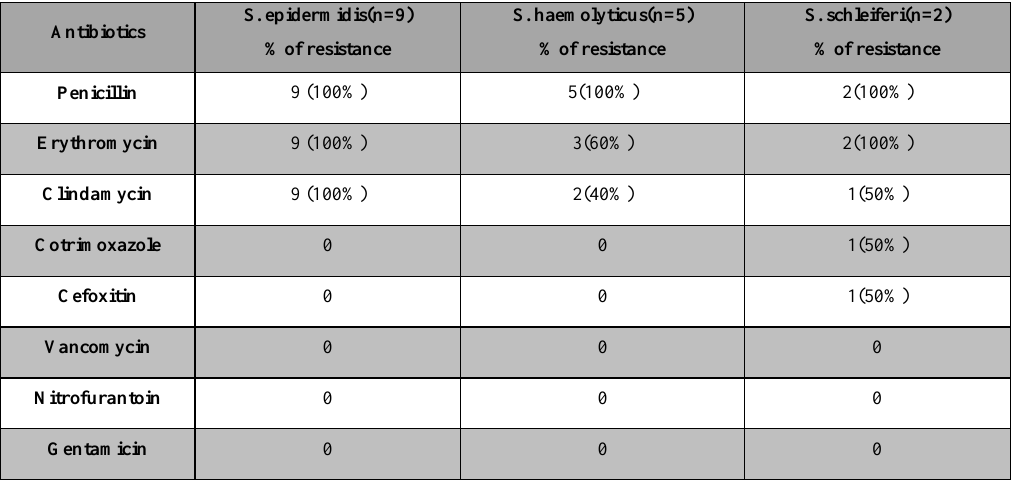
Table 9. Antibiotic resistance pattern of Dnase positive